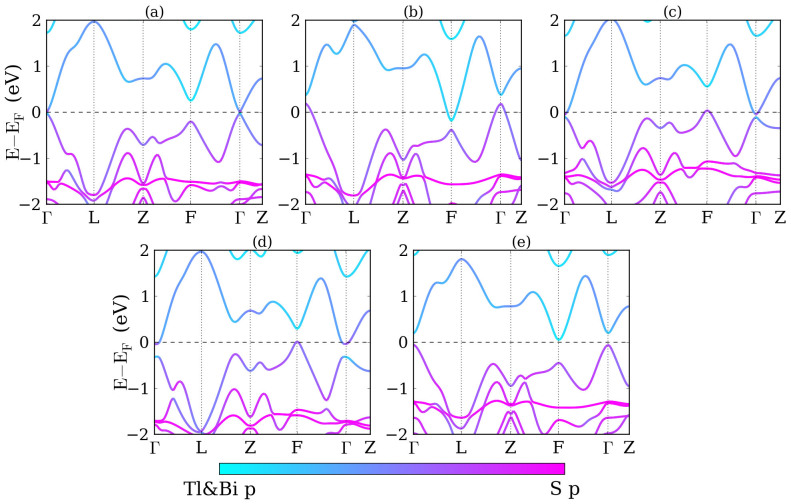
Band structures of TlBiS2 (a) without strain, with (b) −5%, (c) 5% biaxial strain as well as (d) −6% and (e) 6% uniaxial strain.